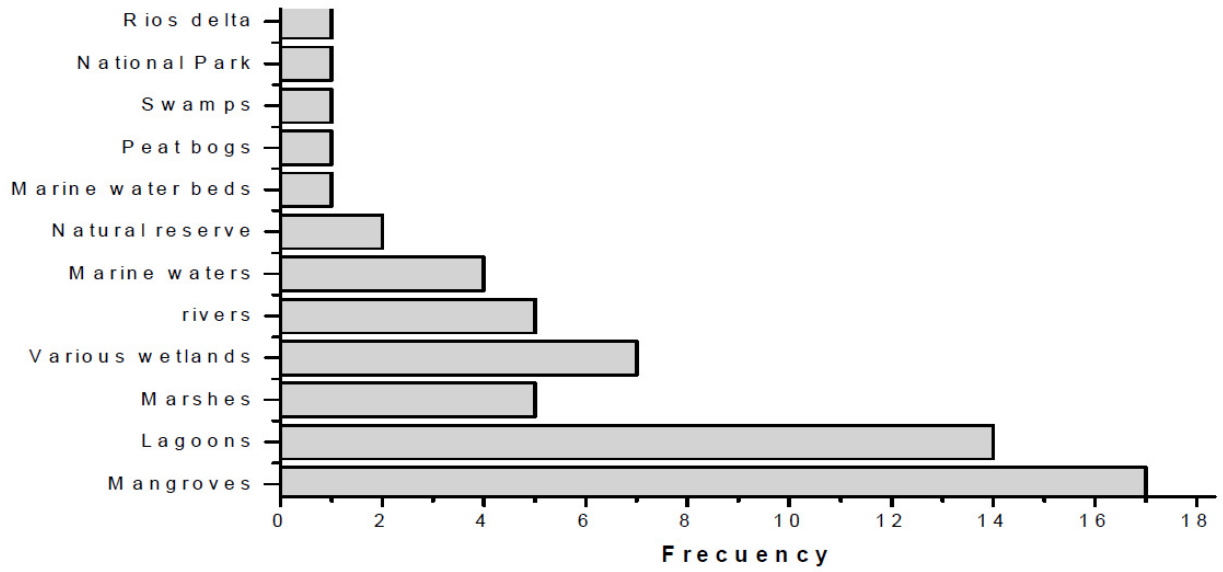
Figure 5. Frequency Distribution of Incident Factors affecting wetlands in America.